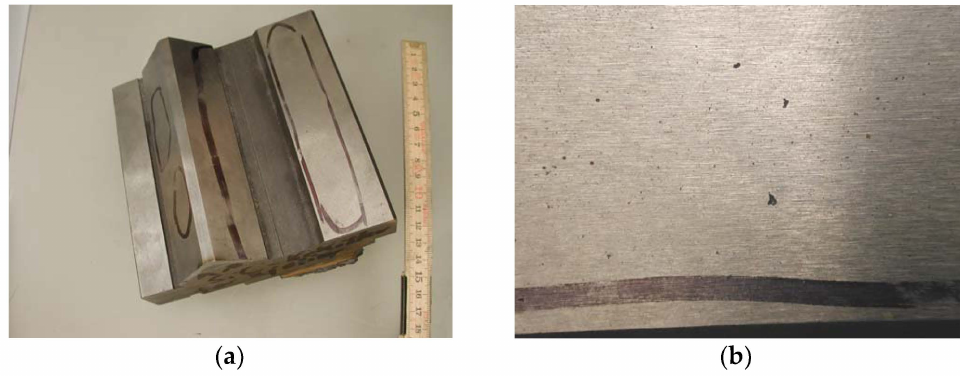
Figure 7. ( a ) Place of appearance of porosity in lathe bed casting and (unit: cm) ( b ) appearance of defect. The voids had irregular shapes, and one can see areas that were devoid of graphite at their boundaries (as shown in Figure 8). However, the interior of the voids was covered with graphite (shown in Figure 9). The irregular shapes of the pores is similar to a